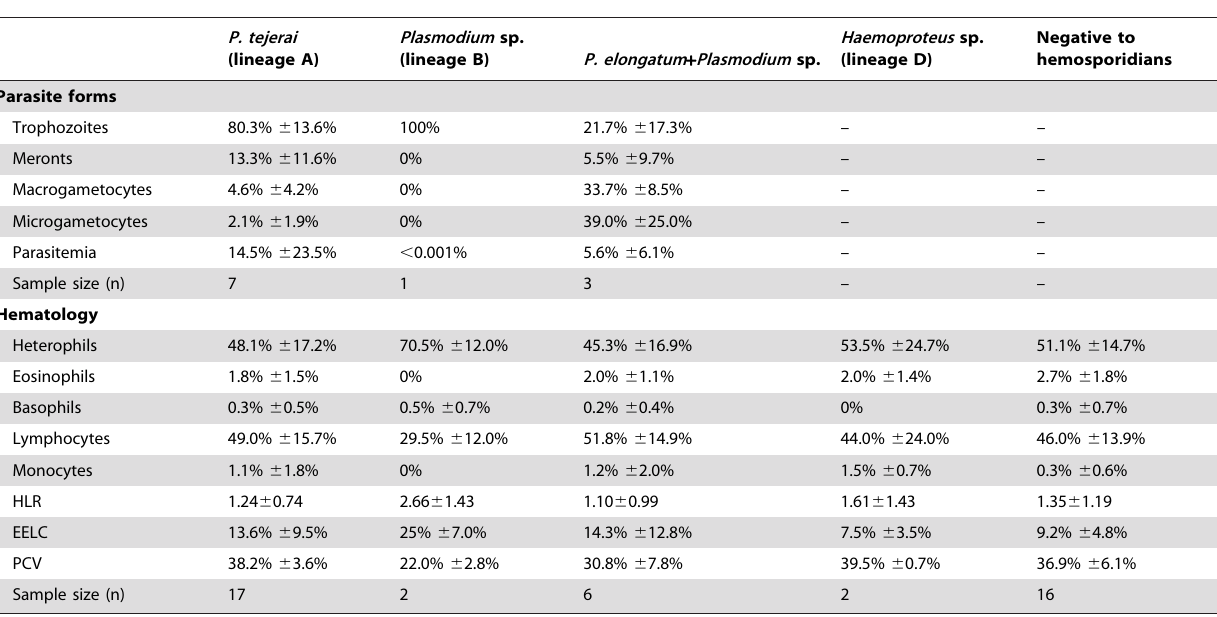
Table 3. Hematological results and quantification of blood parasites in blood smears (Mean 6